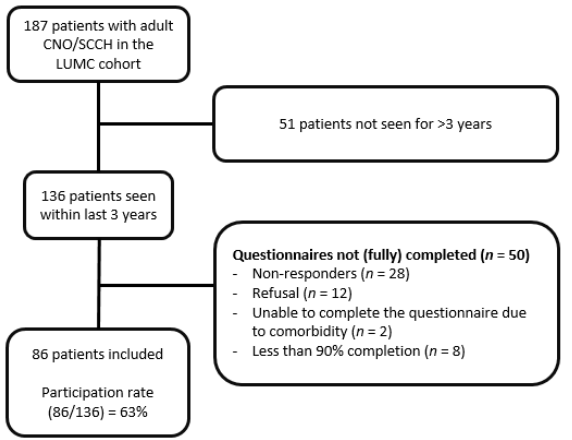
Figure 1. Flowchart of patient inclusion and participation rate. CNO/SCCH: Chronic Non-Bacterial Osteomyelitis/Sternocostoclavicular hyperostosis, LUMC: Leiden University Medical Center.